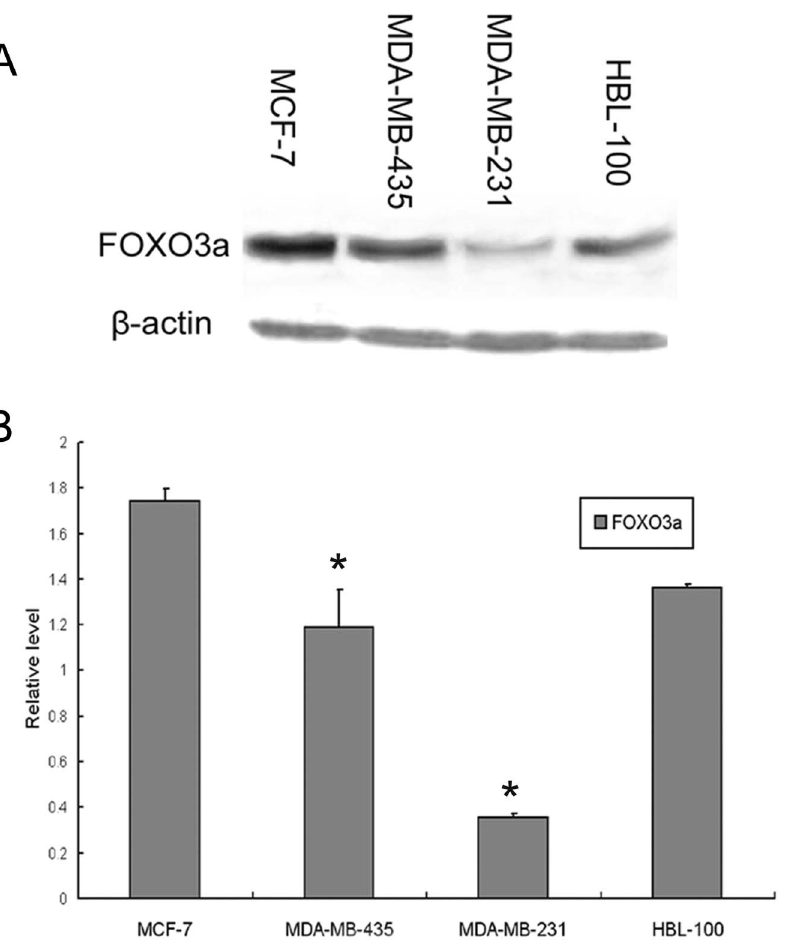
Figure 4. Foxo3a protein expression in distinct ER + and ER 2 breast cell lines. (A) A Western blot analysis of endogenous Foxo3a abundance in three human breast cancer cell lines and one normal human breast epithelial cell line: MCF-7 (ER + ), MDA-MB-435(ER 2 ), MDA-MB- 231(ER 2 ) and HBL 100. The total protein extracted from the indicated cell lines was analyzed using a polyclonal antibody against human Foxo3a. b - actin was used as a loading control. (B) The bar graph below demonstrates the level of Foxo3a expression compared with the expression of b -actin. Error bars reflect the standard error from at least 3 independent experiments. * indicates p , 0.05 for comparison between MCF-7 and MDA-MB-435 or